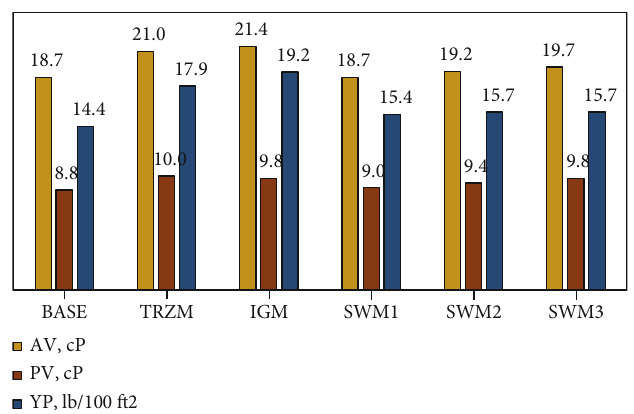
Figure 3: The apparent and plastic viscosities and yield points of the formulated water-based muds.